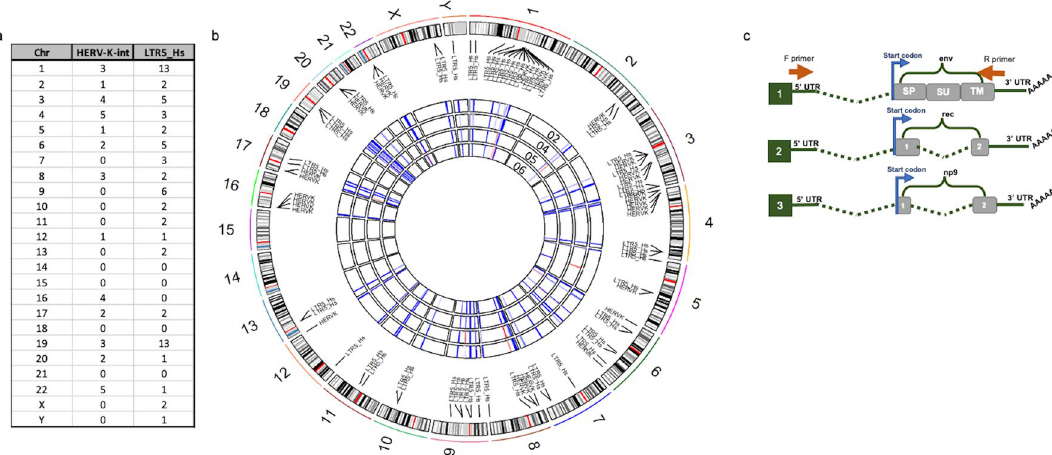
Figure 4. RNA sequencing of AT/RT cell lines. ( a , b ) HERV-K (HML-2) internal coding genes and LTR5_Hs are expressed from most chromosomes. ( a ) Table shows quantity of loci expressed on each chromosome (Chr). ( b ) Graphical depiction of HERV-K (HML-2) internal coding genes in (HERV-K-int) and LTR5_Hs in (long terminal repeat 5 human specific) expression in four AT/RT cell lines. The outer ring is comprised of the chromosomes from the human genome with the list of both “HERV-K-int” (internal coding sequence) and LTR5_Hs loci and black lines connecting them to their approximate location on the chromosome. The four rings in the center correspond to the CHLA 02, 04, 05, and 06 cell lines with the 02 cells being the outermost circle and the 06 cells the innermost circle. The segments of the central circles represent the chromosomes; blue and red lines correspond to the level of expression of either the LTR5_Hs or HERV-K (HML-2) labeled at that location (red denotes higher expression, blue denotes less). ( c ) Scheme for PCR amplification and Sanger sequencing validation of HML-2 transcripts. Shows a representation of primer position relative to potential env, rec, and np9 transcripts which are transcribed in the AT/RT cells. The forward primer used for amplifying env (1), rec (2), and np 9 (3) transcripts is positioned in the 5’ UTR while the reverse primer is positioned in the 3’ UTR. Because both primers are in the UTRs, env, rec and np9 transcripts can all be amplified with the same primer set. The image in ( b ) was generated with the RCircos package version 1.2.1 (https:// bmcbi oinfo rmati cs. biome dcent ral. com/ artic les/ 10. 1186/ 1471- 2105- 14-